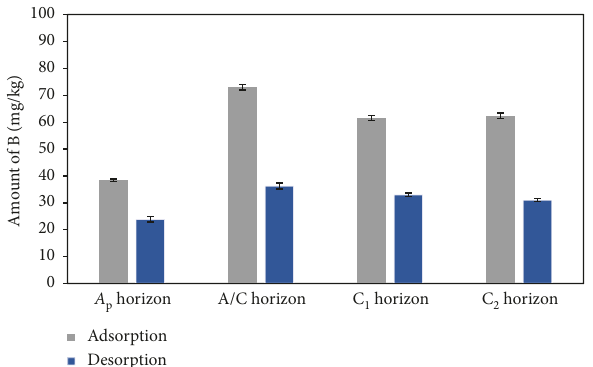
Figure 5: Comparison between adsorbed and desorbed B amounts of the different horizons of the studied